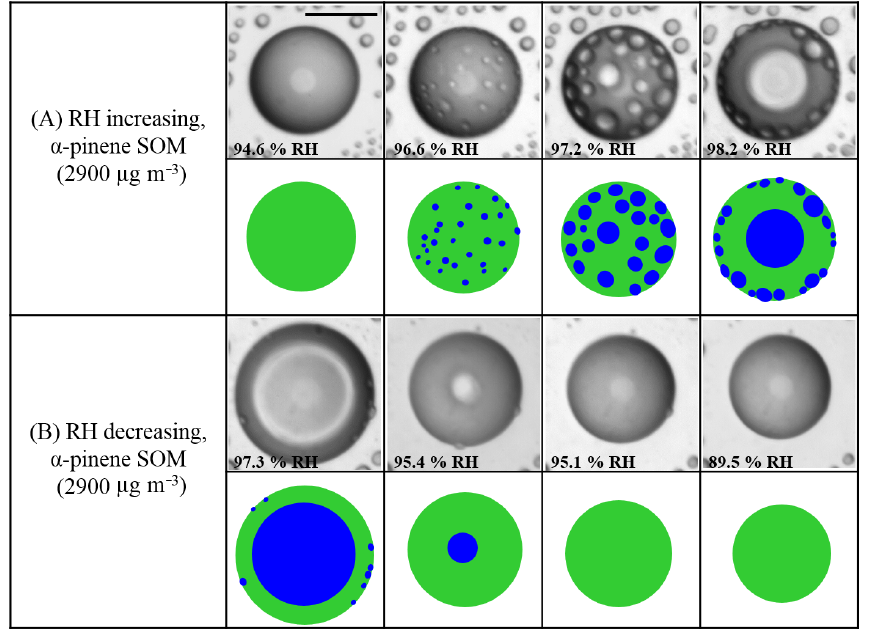
Figure 2. Effect of RH cycles on α -pinene-derived SOM for SOM produced at 2900µgm − 3 . Illustrations of the images are shown for clarity. Green: SOM-rich phase. Blue: water-rich phase. Size bar is